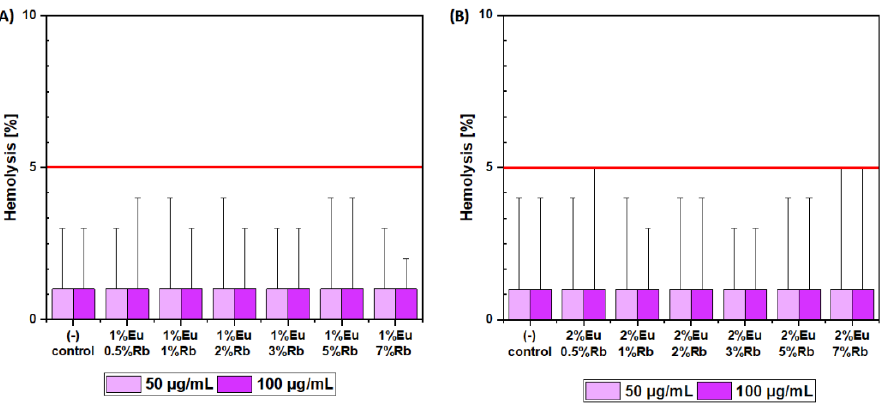
Figure 11. Hemoglobin release after 24 h incubation in ( A ) Ca 10 − (0.1 + x) Eu 0.1 Rb x (PO 4 ) 6 (OH) 2 and ( B ) Ca 10 − (0.2 + x) Eu 0.2 Rb x (PO 4 ) 6 (OH) 2 , where x equals 0.5, 1, 2, 3, 5, 7 mol% of Rb + ions. The red line is equal to 5% of physiological hemoglobin release. The results were compared with red blood cells treated with PBS buffer (1% of hemolysis — negative control) and 1% SDS (100% of hemolysis — positive control).